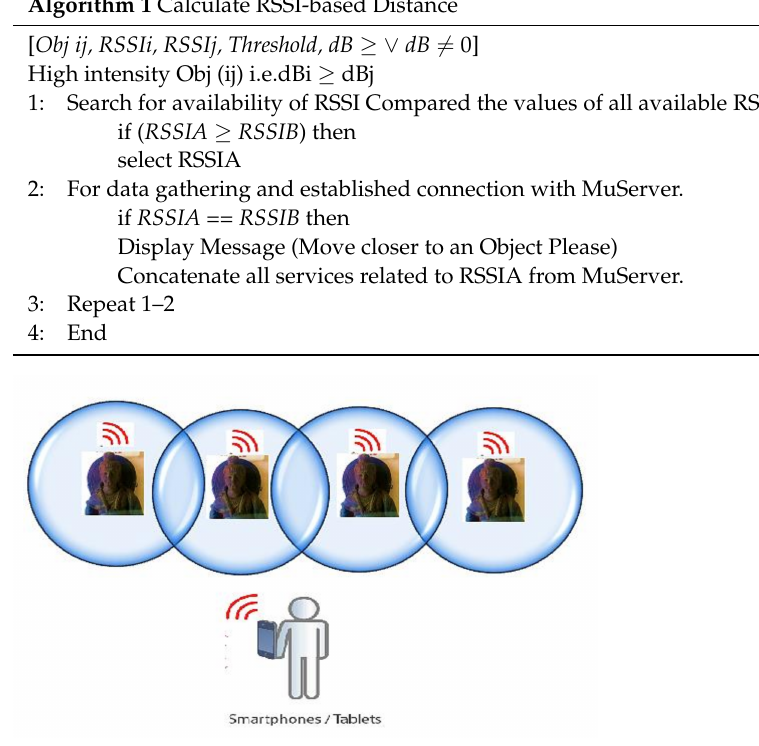
Figure 3. Sensor premises around an object.